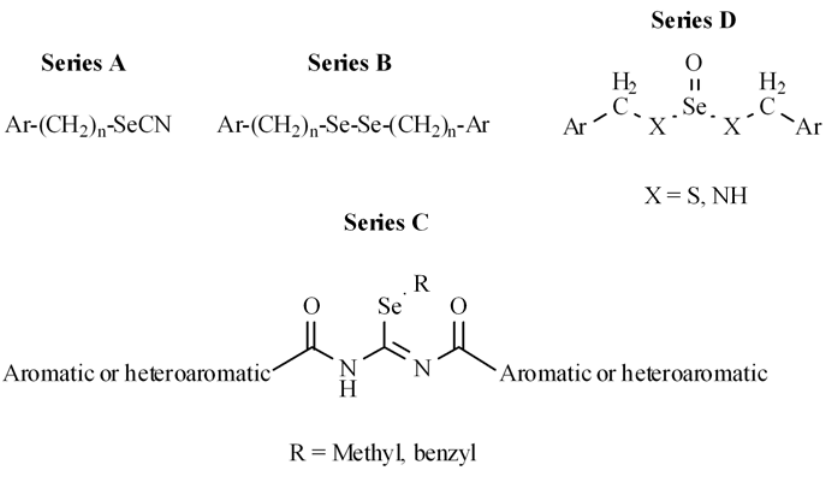
Figure 4. General chemical structures for the series of compounds studied A - D